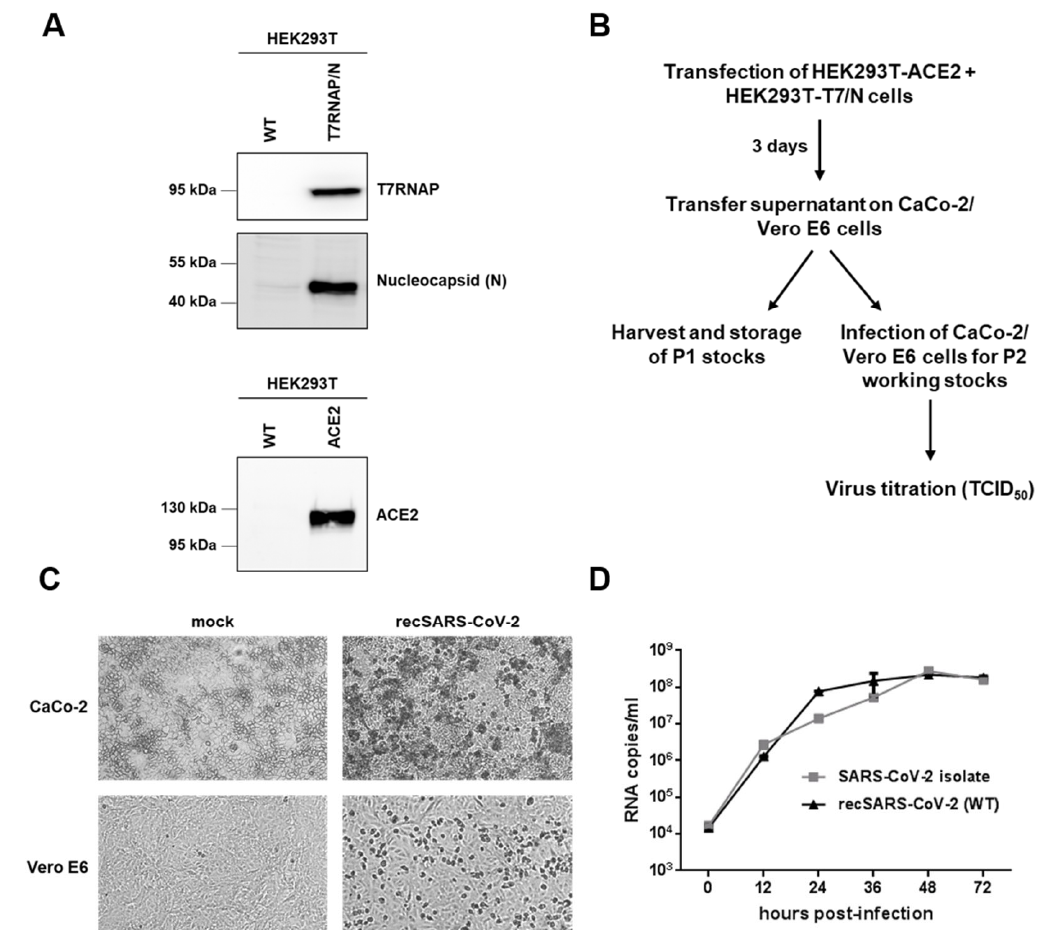
Figure 2. Rescue of recSARS-CoV-2. ( A ) Western blot analysis of HEK293T cells stably expressing either T7 RNA polymerase (T7RNAP) and the viral nucleocapsid protein (N) or the ACE2 receptor upon lentiviral transduction. ( B ) Illustration of the approach followed to rescue recSARS-CoV-2. A coculture of HEK293T-ACE2 and HEK293T-T7RNAP/N cells was transfected with pBSCoV2. After three days, the supernatant was transferred on CaCo-2 or Vero E6 cells to obtain the first passage (P1) virus stocks. P1 stocks were used to infect CaCo-2 and Vero E6 cells for the P2 working stocks, respectively. The virus titers were determined by TCID 50 titration. ( C ) Visualization of the cytopathic effect (CPE) in recSARS-CoV-2 infected CaCo-2 and Vero E6 cells three days after infection. Mock-infected cells are shown as the control. ( D ) Growth kinetics of a SARS-CoV-2 clinical isolate compared to recSARS-CoV-2. CaCo-2 cells were infected with the clinical isolate or the recombinant SARS-CoV-2 virus at an MOI of 0.005. Cell culture supernatants were collected at the indicated time points post-infection, and viral copies were determined by RT-qPCR targeting the viral polymerase RdRp. Data are presented as the means of triplicates ± SD.